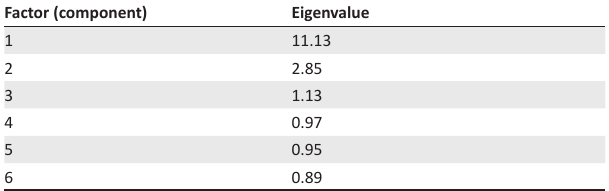
TABLE 6: Eigenvalue